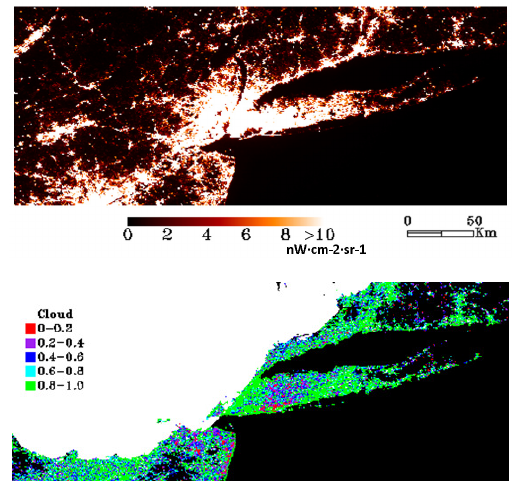
Figure 2. (A) The NASA Black Marble NTL before the Hurricane Sandy; (B) The percent of normal NTL power outage spatial extent. The NTL on November 1 is used for post- hurricane. The white colour areas were covered by cloud. Puerto Rico experienced significant power outage after the Hurricane Maria (Figure 3). The percent of normal is less than 40% over most area of the Puerto Rico.